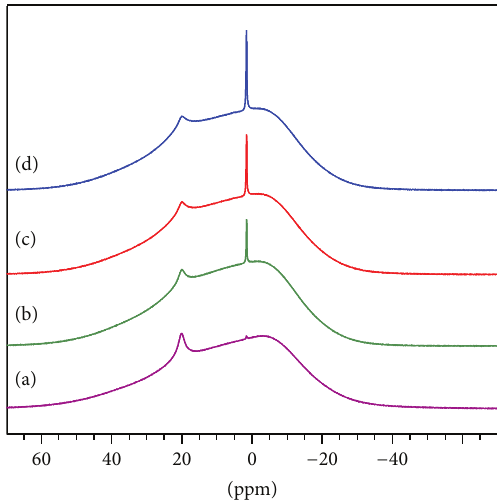
Figure 2: 11 B-NMR spectrum of reaction mixture obtained at the initialmolarratioof BHPU :BA1 : 2attemperature110 ∘ Cmadeafter (a) homogenization of reagents, (b) 5, (c) 6, and (d) 7 hours of